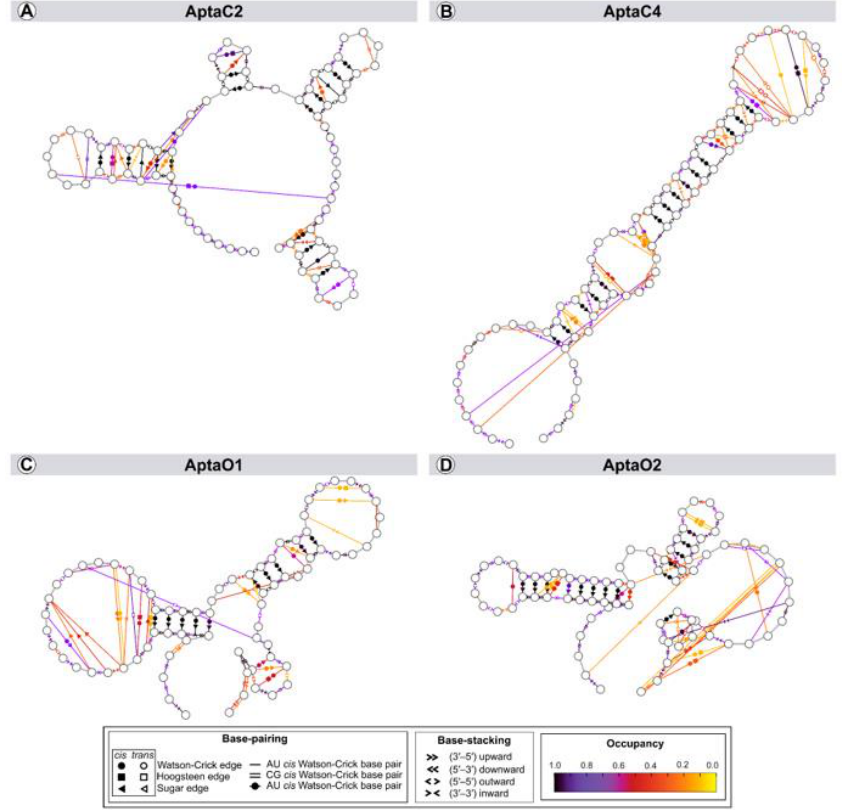
Figure 6. Dynamic secondary structure representation of aptamers AptaC2 ( A ); AptaC4 ( B ); AptaO1 ( C ); and AptaO2 ( D ). The extended secondary structure annotation follows the Leontis – Westhof classification (see legend caption). The color scheme shows the fraction of frames (occupancy) within the system for which the interaction was formed.